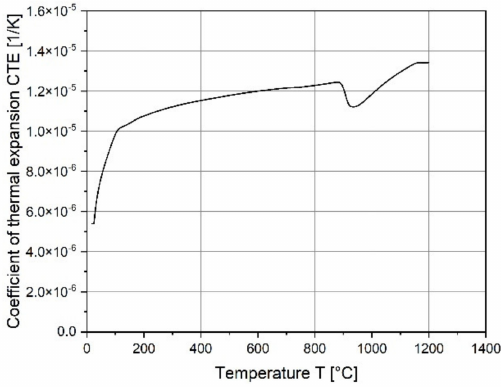
Figure 15. Temperature dependent coefficients of thermal expansion CTE for as-built FeCr-10V.